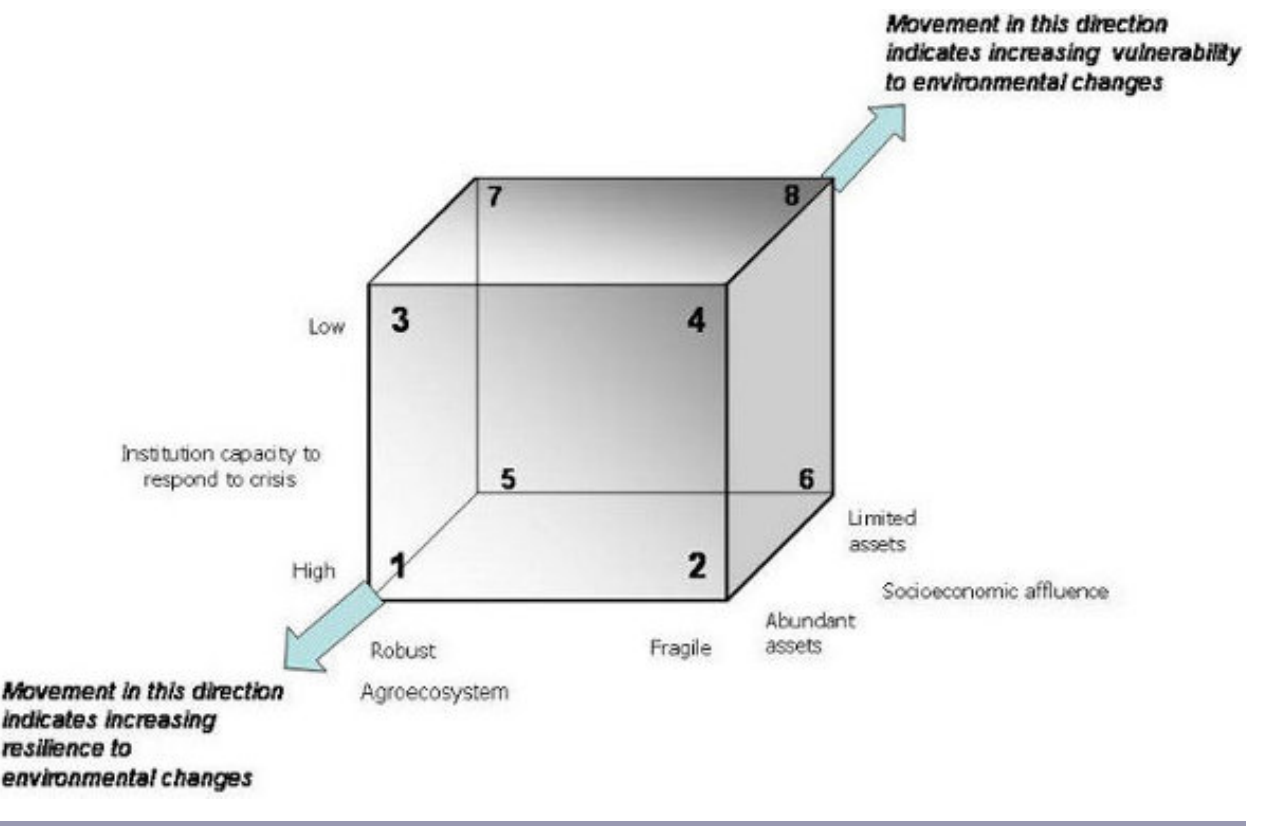
Fig. 1. Generic vulnerability framework made up of three dimensions the literature suggests are important in assessing vulnerability: (1) agroecosystem resilience that measures the extent to which the agroecosystem can tolerate climatic shocks and remain productive; (2) socioeconomic affluence that measures the extent to which households will have access to the assets needed to maintain livelihoods in the event of an environmental shock; and (3) institutional capacity that measures the extent to which institutions in society will provide effective crisis